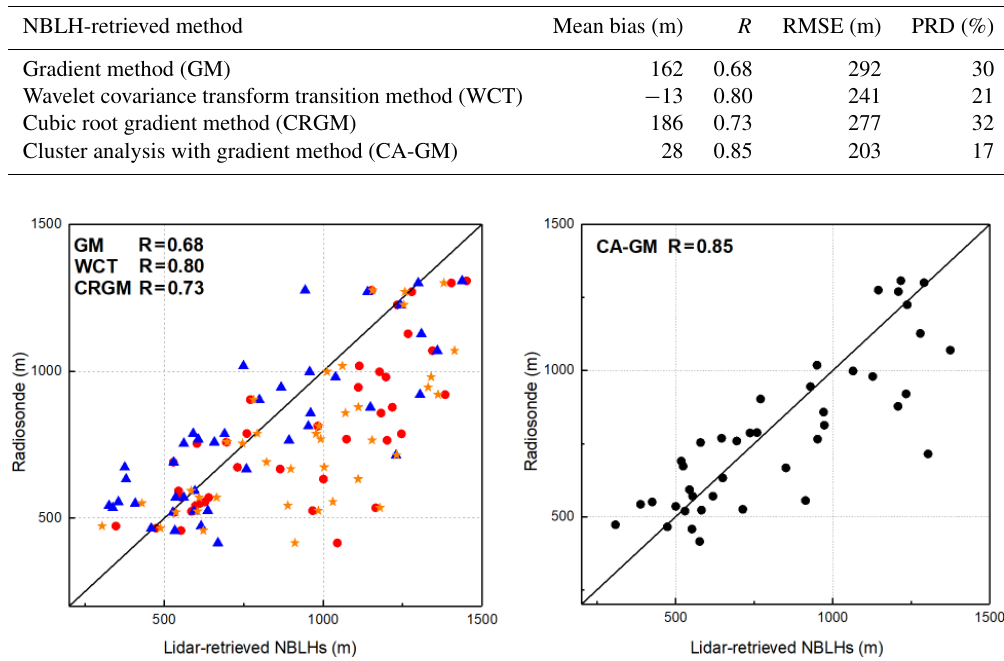
Table 2. Statistical parameters of the lidar-retrieved algorithm compared with radiosonde measurement. Mean bias (MB), correlation coeffi- cient ( R ), root-mean-square deviation (RMSE), and the percent of relative absolute bias difference (PRD) are shown below.